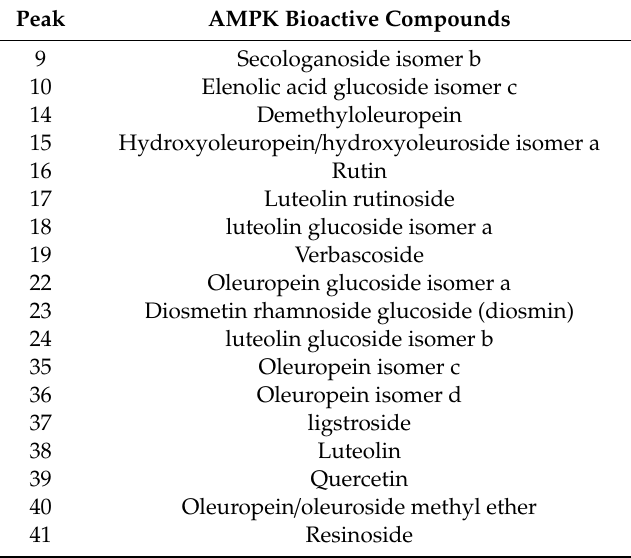
Table 3. Compounds identified in olive leaf extracts with the potential to modulate AMPK.